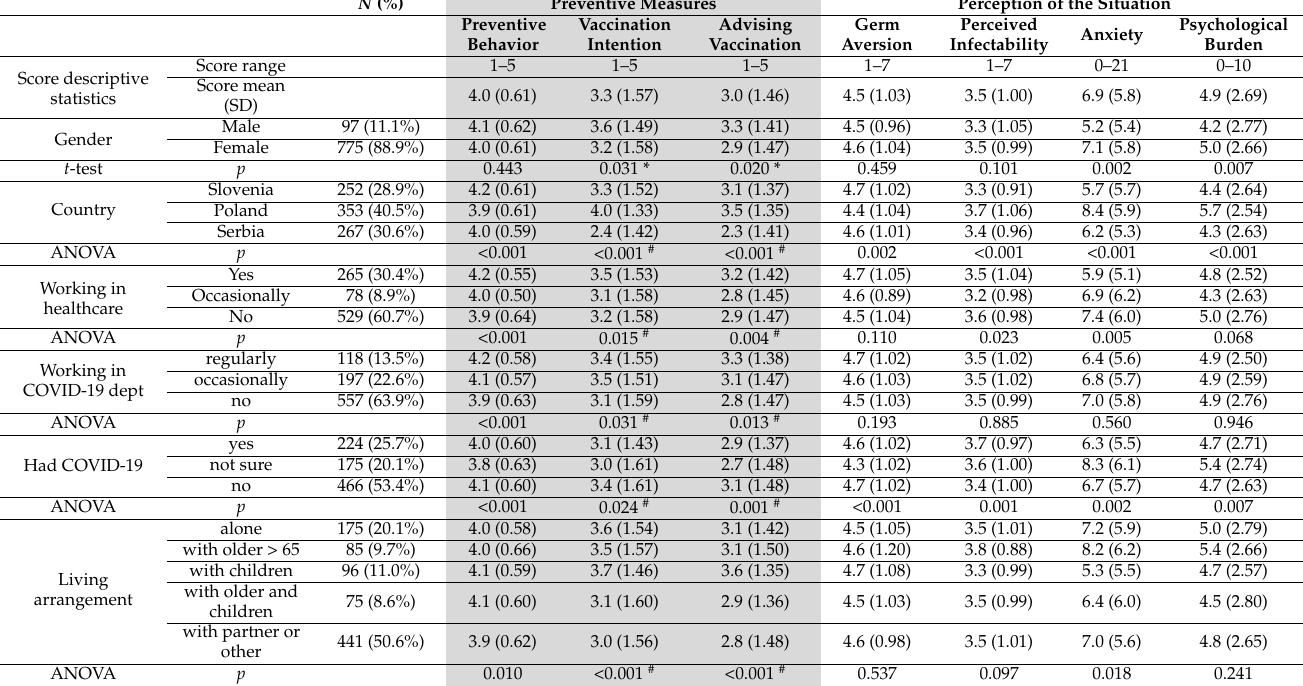
Table 2. Descriptive statistics for variables defining preventive behavior (preventive behavior score, vaccination intention, advising vaccination—shaded fields) and analyzed scores reflecting respondent’s perception (germ aversion, perceived infectability, anxiety, and psychological burden) and differences in the analyzed scores according to demographic